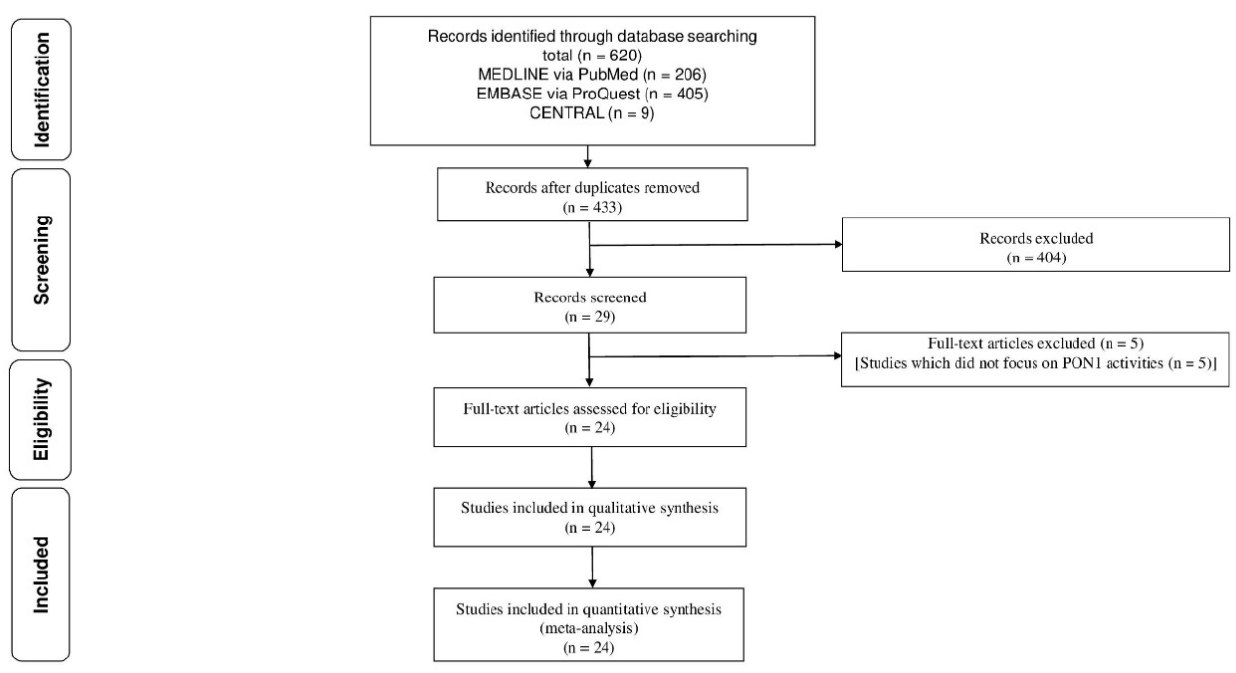
Figure 1. Flow diagram of selection of articles that reported the PON1 in patients with CKD.